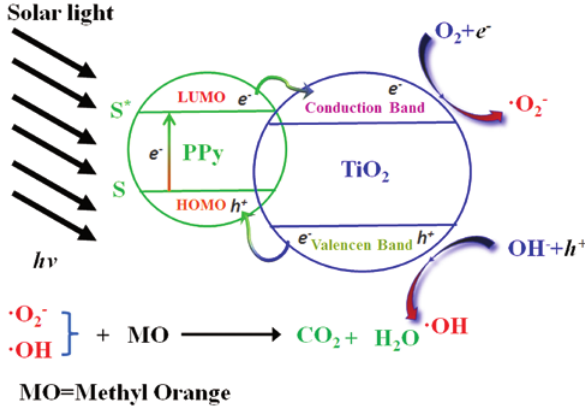
Figure 8 Ultraviolet-visible diffuse reflectance spectra of TiO before and after being sensitized by